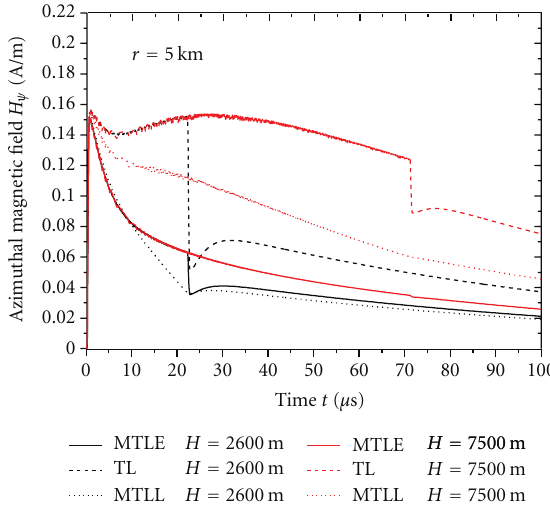
Figure 9: Vertical electric field at 100 km from the channel base for MSS FST, three di ff erent models and two channel heights ( H = 2600 m and 7500 m).